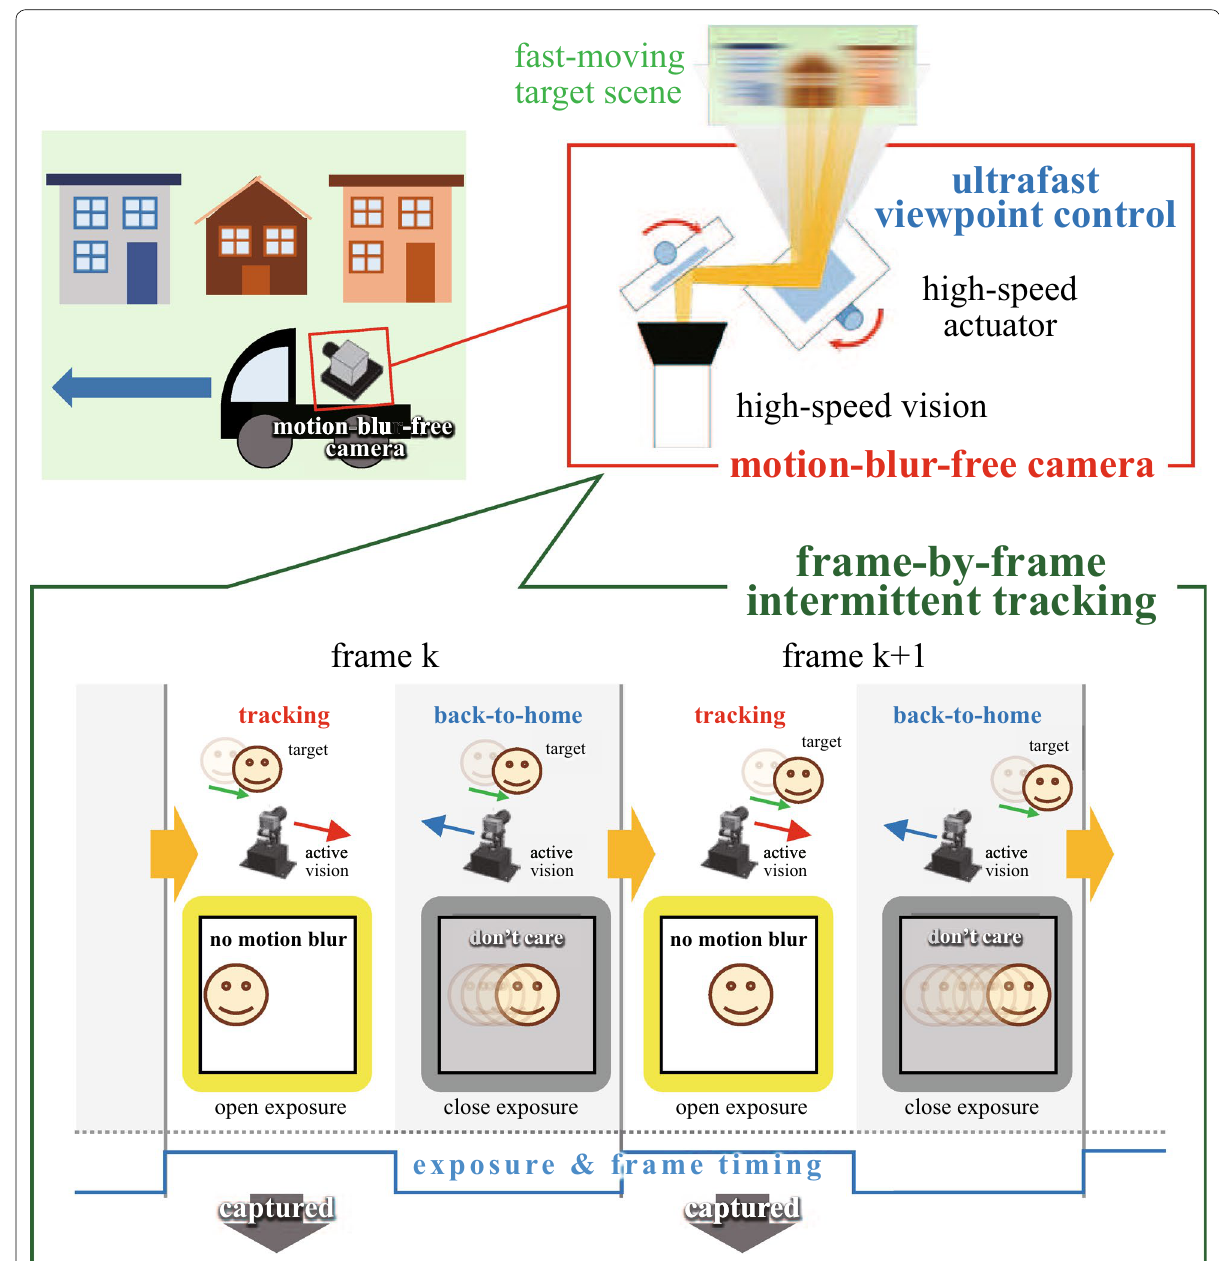
Fig. 1 Concept of frame-by-frame intermittent